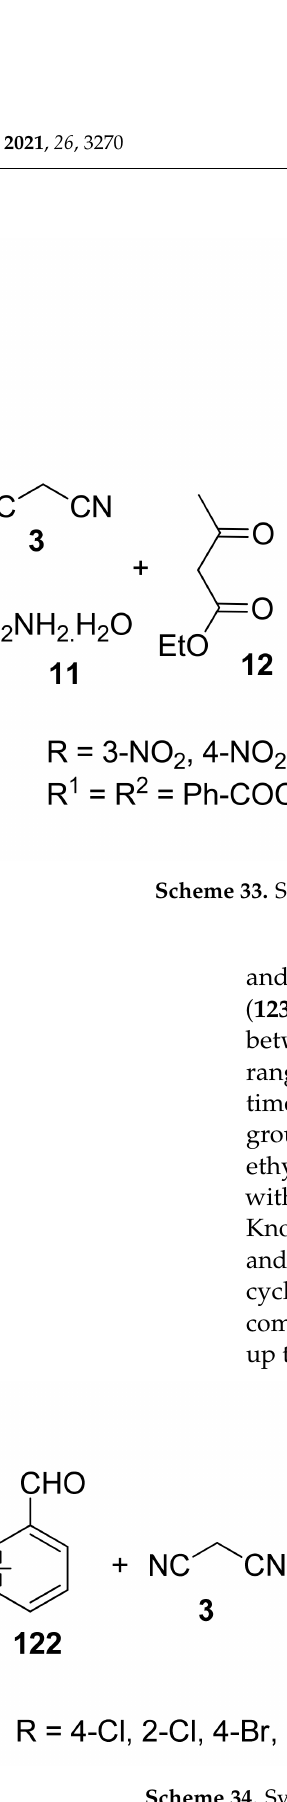
Scheme 34. Synthesis of pyranopyrazole derivatives 123 using bovine serum